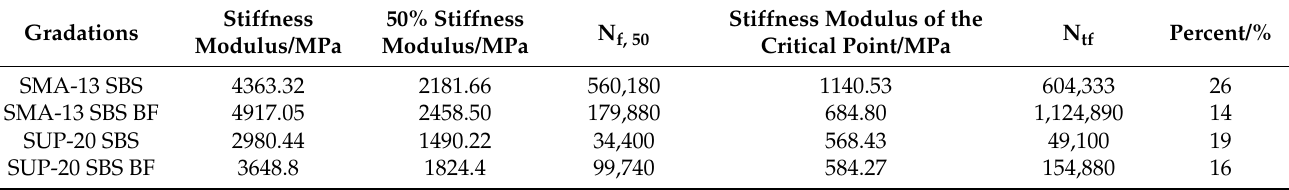
Figure 12. Change rate of dissipated energy: ( a ) SMA-13, ( b ) SMA-13 with BF, ( c ) SUP-20 and ( d ) SUP-20 with BF. Table 6. Stiffness modulus of the critical